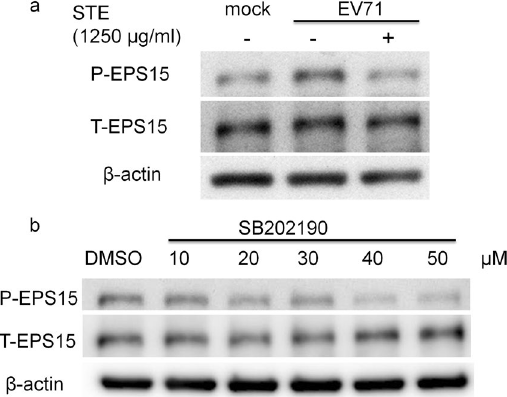
Figure 7. STE reduces EV71-induced phosphorylation of EPS15 at Ser796. ( a ) RD cells were mock- or infected with BrCr at m. o. i. of 20 for 1 h, and treated without or with 1250 µ g/ml STE. Cells were harvested at 7 h p. i. for western blotting with antibodies to total EPS15 and the form phosphorylated at Ser796. The cropped images of the blots are shown. A representative experiment out of three is shown. ( b ) RD cells were pre-treated with DMSO or 10, 20, 30, 40, or 50 µ M SB202190 for 1 h, and infected with BrCr at m. o. i. of 5 for 1 h. The cells were harvested at 9 h p. i. for western blotting with antibodies to phosphorylated and total EPS15. The cropped images of the blots are shown. A representative experiment out of three is